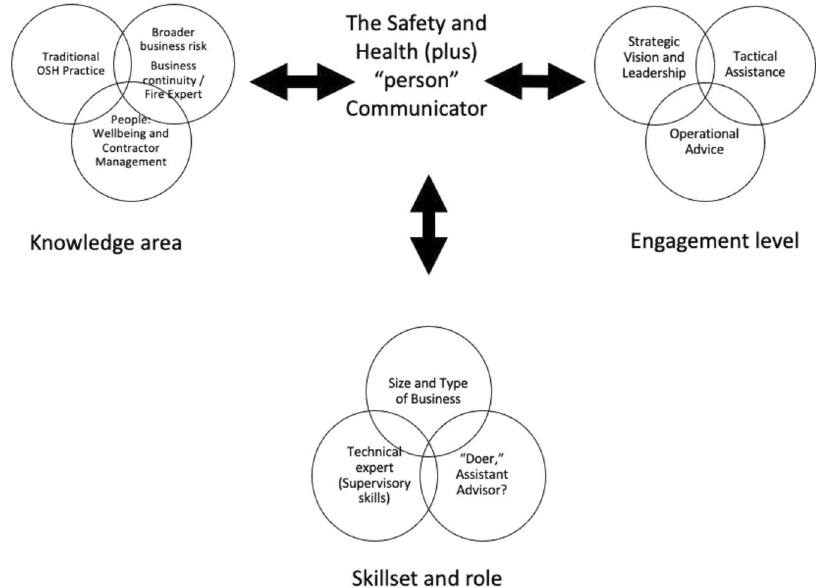
Fig. 2 Diversity of demands of employers on the OSHP and opportunities. This model explores the relationship of the diversity of activities associated with occupational safety and health professionals in corporate roles as well as emerging